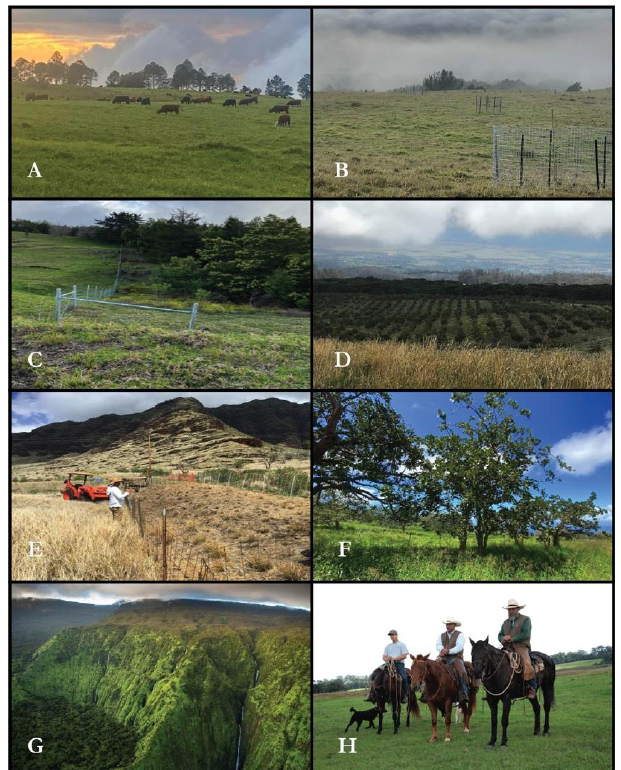
Figure 2. Ranching activities that support ecosystem services in Hawai‘i: ( A ) rotational grazing for food production and local livelihoods ( PC: Leah Bremer ); ( B ) high elevation silvopasture restoration with Acacia koa with the goal of diversifying livelihoods, restoring native tree cover, and potentially increasing fog interception ( PC: Jordan Jokiel ); ( C ) control of high-water-use invasive tree species; invasive black wattle ( Acacia mernsii ) shown here on the edge of grazing lands ( PC: Leah Bremer ); ( D ) Acacia koa restoration for diversified livelihoods and potential carbon sequestration benefits ( PC: Leah Bremer ); ( E ) fire break using grazing as a tool to reduce fire risk ( PC: Clay Trauernicht ); ( F ) Con- servation of wiliwili ( Erythrina sandwicensis ) remnant forest in low elevation grazing lands,